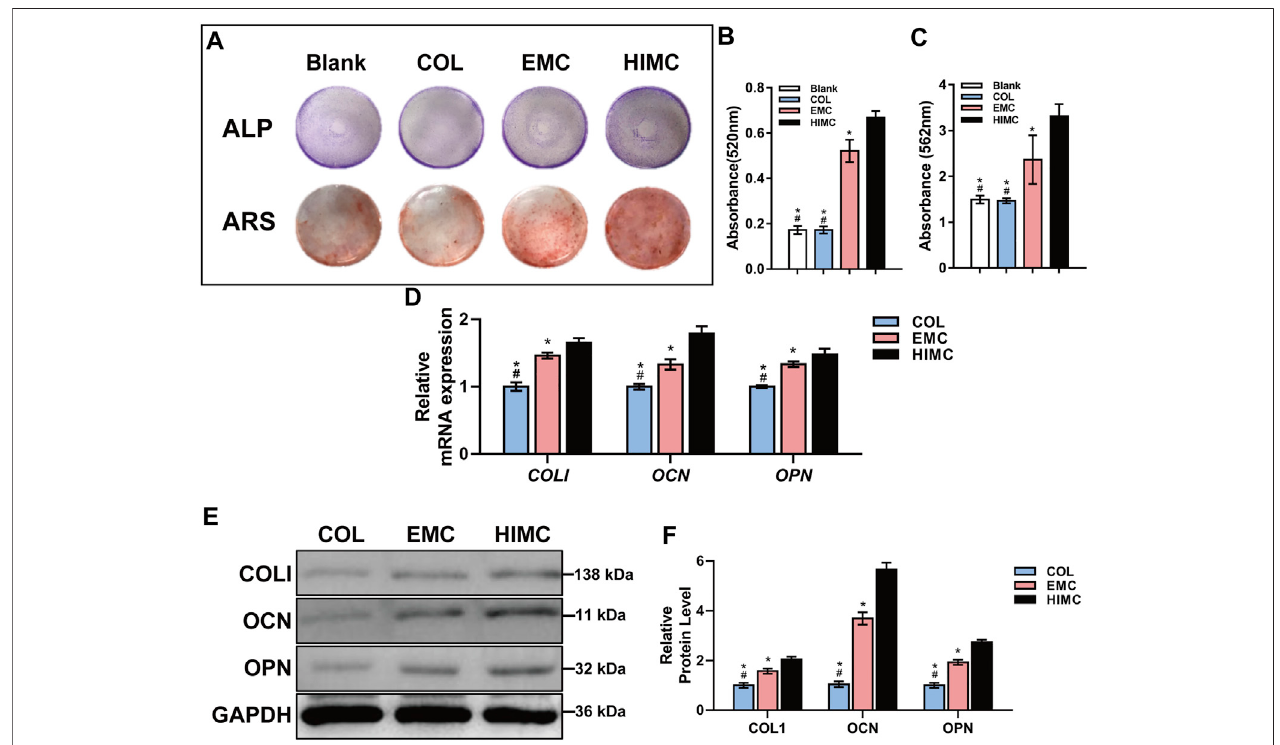
FIGURE3| Osteogenicdifferentiation capacityofBMSCsculturedondifferentmembranes. (A) ALPstainingandARS. (B) Semi-quantitativeresultsofALPactivity assay for absorbance at 520 nm. (C) Absorbance at 562 nm for ARS. (D) mRNA expression levels of COLI , OCN, and OPN as measured by qRT-PCR. (E) Protein expressionlevelsofCOLI,OCN,OPN,andGAPDHasquanti fi edbyWesternblot. (F) Gray-scaleanalysisofWesternblots.Dataareexpressedasmean±S.D.* p < 0.05 vs. HIMC membrane; # p < 0.05 vs. EMC